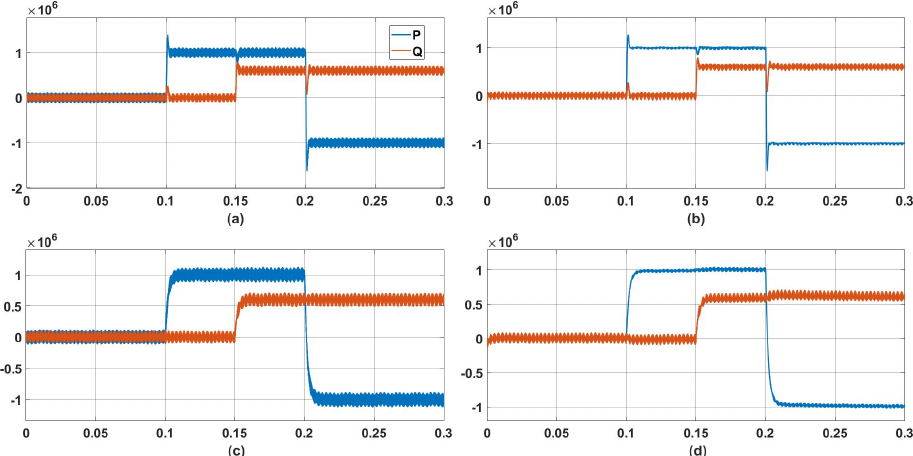
Figure 30. Power under step changes in the case of ( a ) 2L- αβ , ( b ) 3L- αβ , ( c ) 2L-dq and ( d ) 3L-dq.